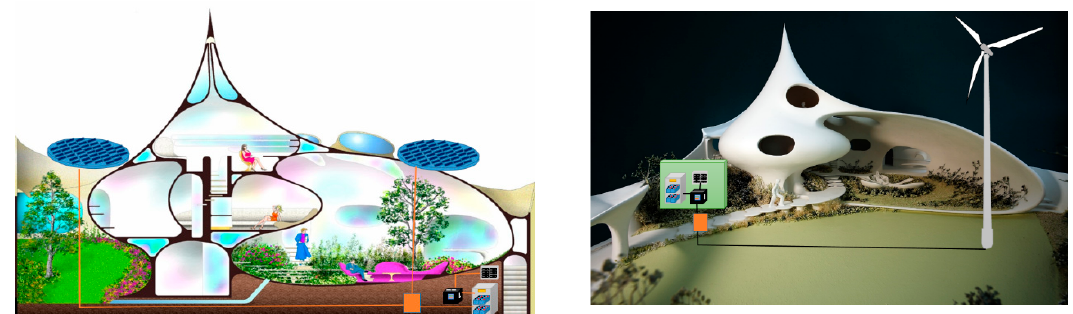
Figure 3. Organic architectures raised with renewable energy equipment inspired in [4].